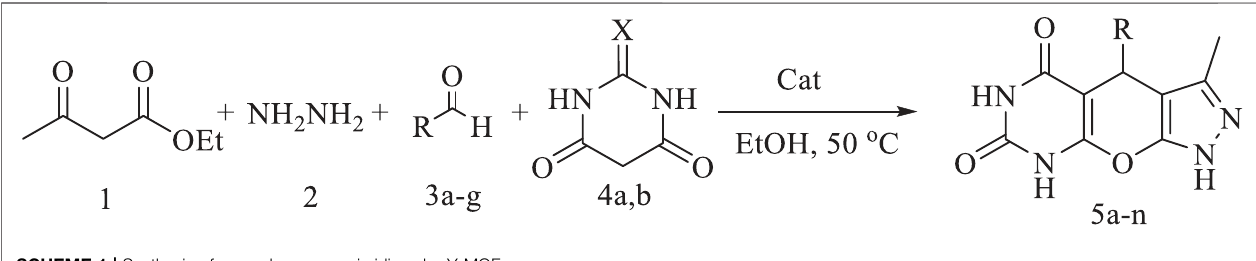
SCHEME 1 | Synthesis of pyrazolopyranopyrimidines by Y-MOF.